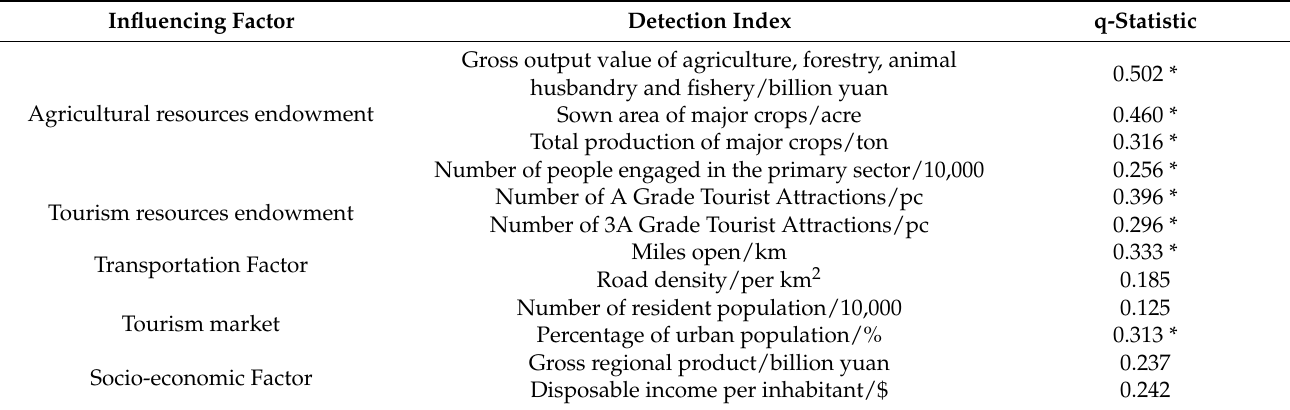
Table 4. Detection results of the influencing factors of rural tourism resources in Guangdong